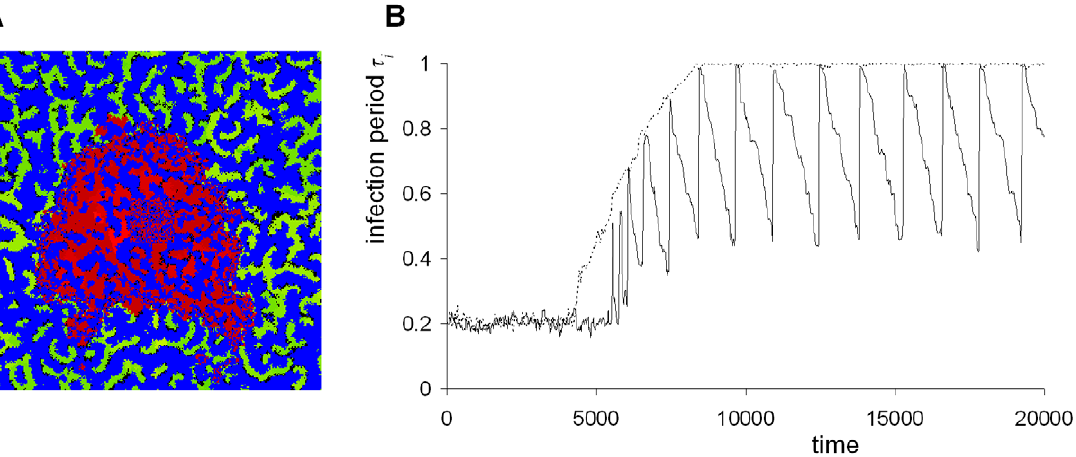
Figure 5. Evolutionary cycling induced by a small heterogeneous region. A: Pattern after 9950 time steps. The large infection periods (red) spread from a 40 6 40 cell heterogeneous center of the field and replace the short infection periods (green) in the periphery (for color legend see Fig. 3B). B: The evolutionary dynamics in the center of the field slowly evolve to maximal infection period (dotted line), and induce sustained large amplitude evolutionary cycling in the rest of the field (solid line). Field size is 300 6 300 cells with periodic boundary conditions. Infectivity is set at b =32, and resistant period is fixed at t R =1. In the middle of the field, in a 40 6 40 cell region, the resistant period is normally distributed with mean t R =1 and standard deviation=0.3. For initial conditions a susceptible field is seeded with 100 randomly located 10 6 10 blocks of infected individuals with t I =0.2 and subsequently with 100 random 10 6 10 blocks of resistant individuals. The average infection period is plotted for the 40 6 40 cells in the middle of the field (dotted line), and for 40 6 40 cells in the left upper corner (solid line). Mutation step size is D t i =0.01, and mutation rate is m